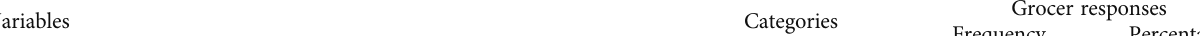
Table 2: Grocer responses regarding food safety practices in the Woldia University students ’ canteen, May-July 2021 ( n = 291 ).